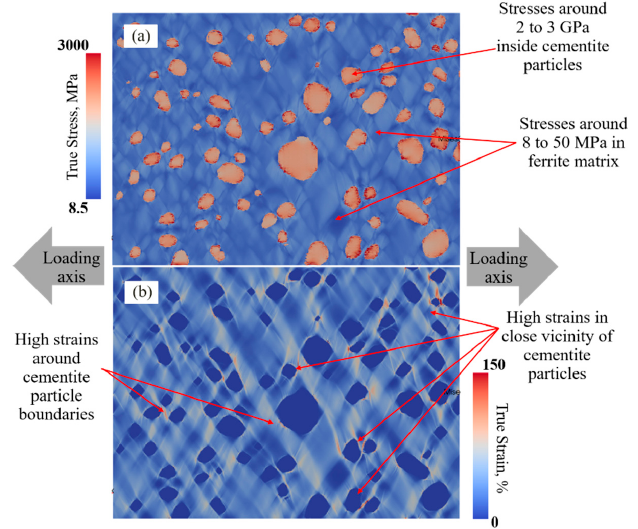
Figure 9. Visualization of spheroidized steel local results for the last frame: ( a ) local von Mises– Cauchy stress in different phases; ( b ) local von Mises logarithmic strain in different phases.